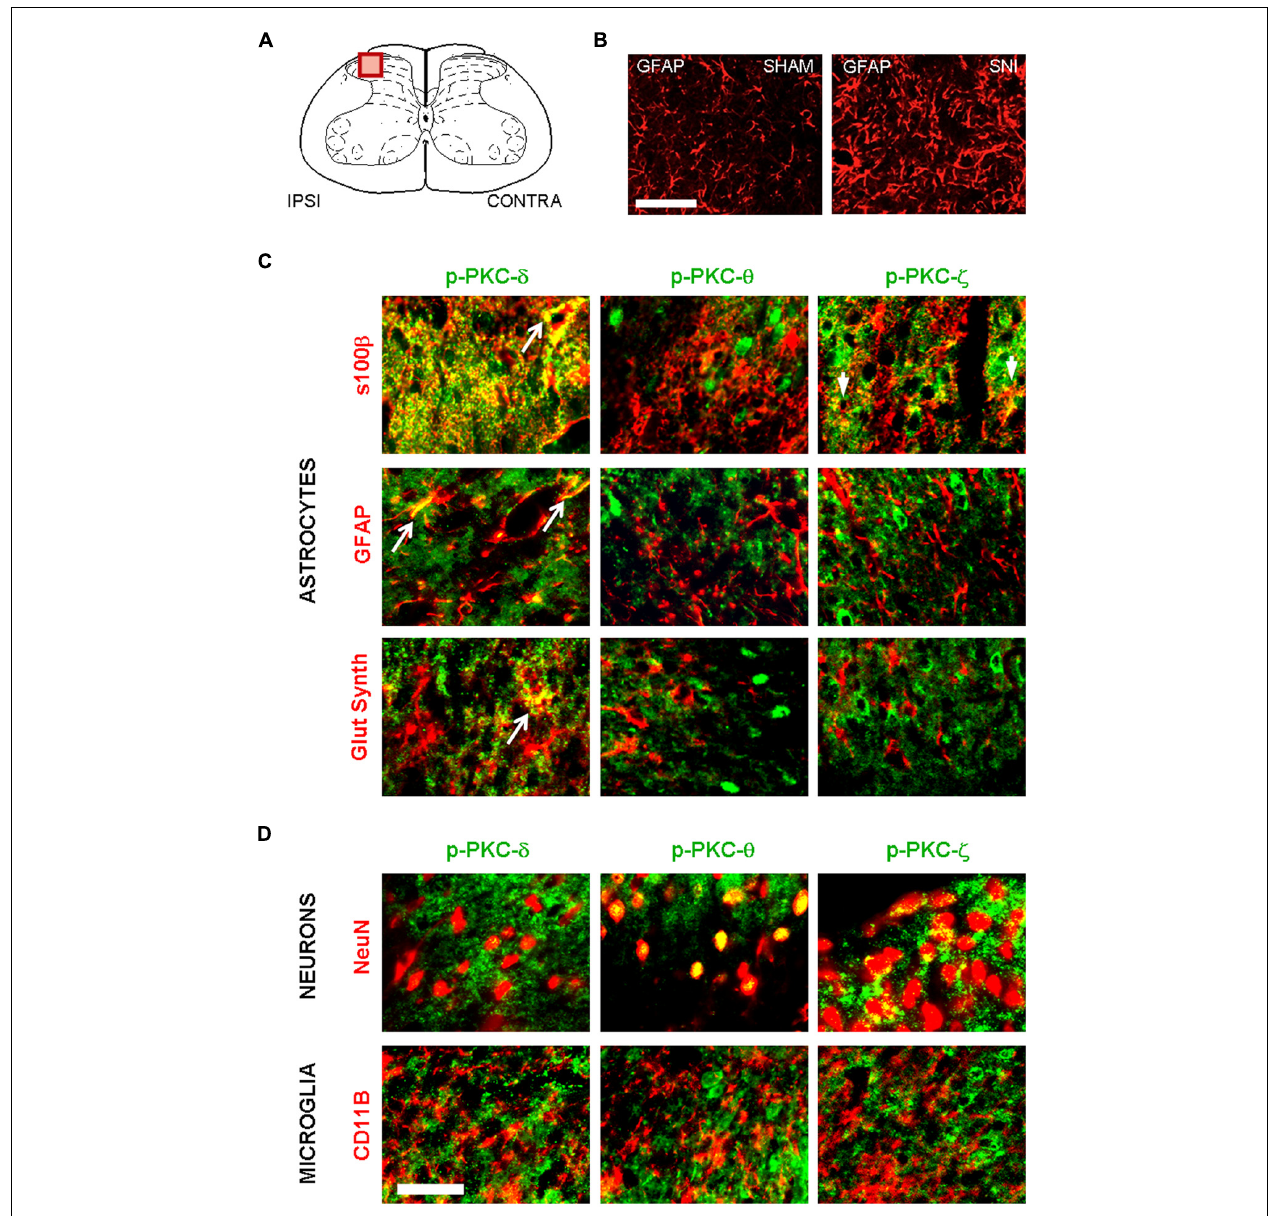
astrocytes (s100 β , GFAP and glutamine synthetase, red) and activated PKC- δ and - ζ (green, first and third columns). No overlap was found between phospho PKC θ and astrocytes. (D) Phospho-PKC- θ and - ζ , but not phospho-PKC- δ colocalizewith neuronal marker (NeuN, upper